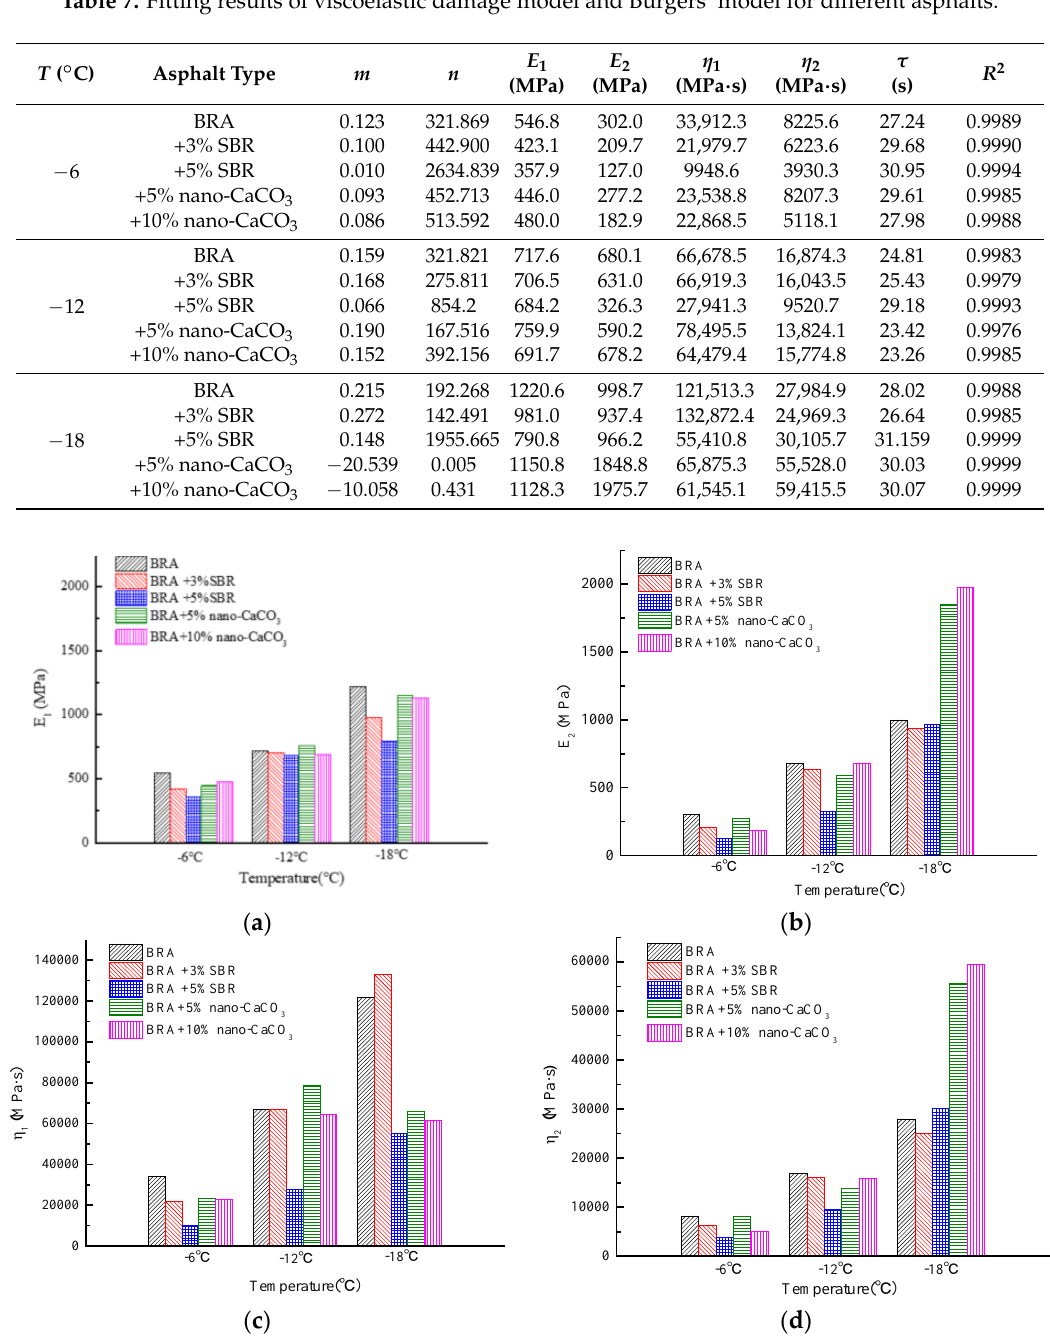
Figure 11. The comparison among viscoelastic damage model’s parameters of creep compliance: ( a ) the viscoelastic parameters ( E 1 ) of the model changed with temperature; ( b ) the viscoelastic parameters ( E 2 ) of the model changed with temperature; ( c ) the viscoelastic parameters ( η 1 ) of the model changed with temperature; ( d ) the viscoelastic parameters ( η 2 ) of the model changed with temperature.